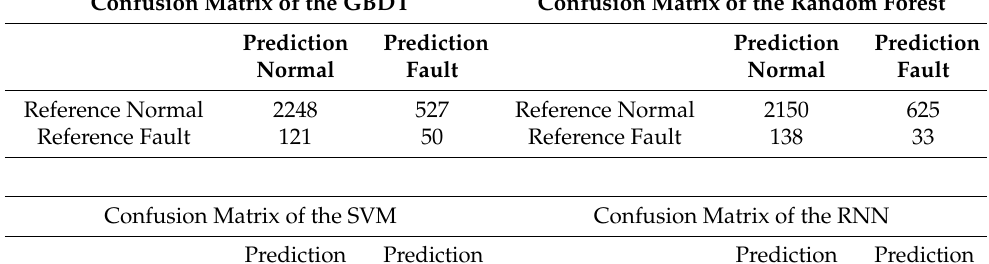
Table 5. The confusion matrix of the GBDT, random forest, SVM, RNN, and CNN. Confusion Matrix of the GBDT